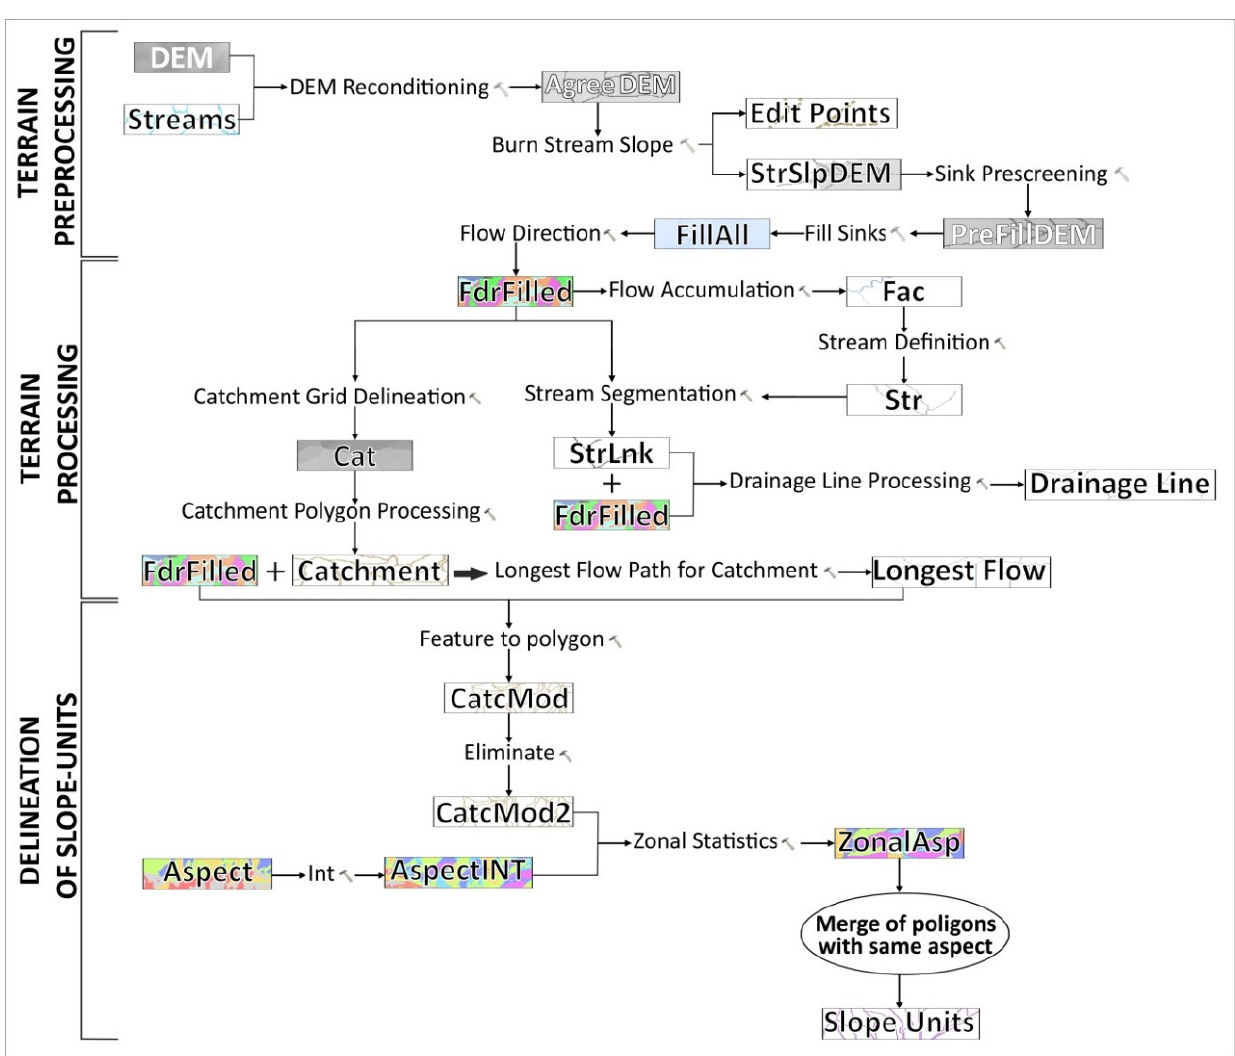
Figure 5. - Workflow of the step-by-step procedure to delineate the SUs. Figure 5. Workflow of the step-by-step procedure to delineate the